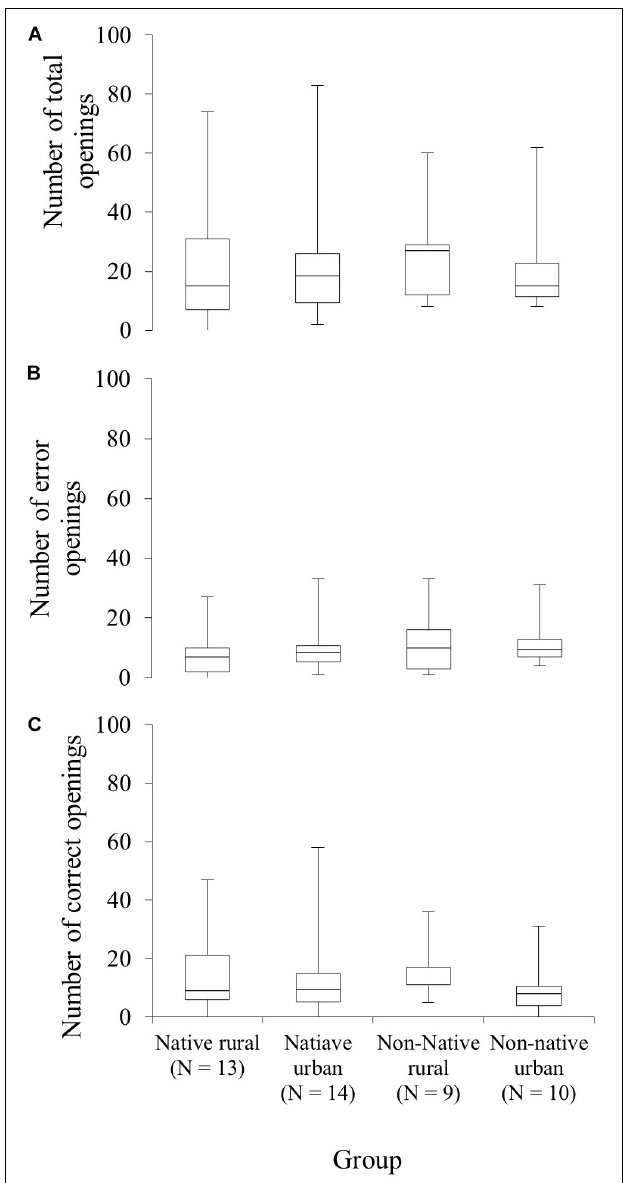
FIGURE 5 | Comparison of the performance of a spatial-learning task across the four squirrel groups (native rural, native urban, non-native rural, and non-native urban group). (A) Proficiency, the total number of first openings in rewarded and non-rewarded containers before reaching the learning criterion. (B) Efficiency, the number of non-rewarded containers opened or error openings before reaching the learning criterion. (C) Accuracy, the number of rewarded containers opened or correct openings before reaching the learning